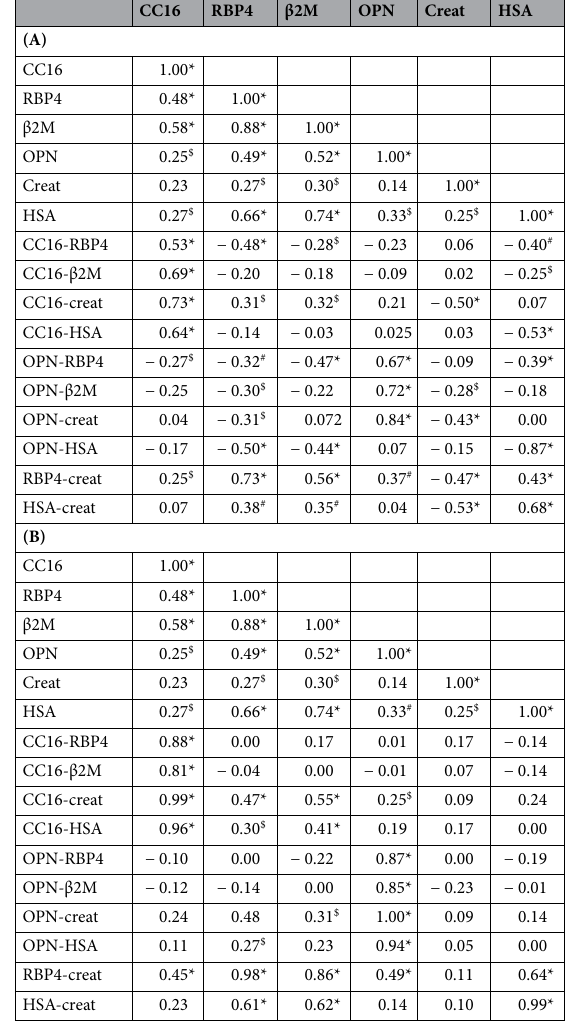
Table 3. Pearson’s correlation coefficient between the detected urinary proteins biomarkers. Pearson’s correlation coefficient between the detected urinary proteins biomarkers (CC16, OPN) in urine and their potential adjusters (β2M, RBP4, HSA, creatinine) when analytes were (A) adjusted by division with the potential adjusters or (B) adjustment based on the regression coefficient of the two analytes. $ < 0.05; # < 0.01; *< 0.001. All parameters were log transformed. Statistical significance was evaluated by two-tailed